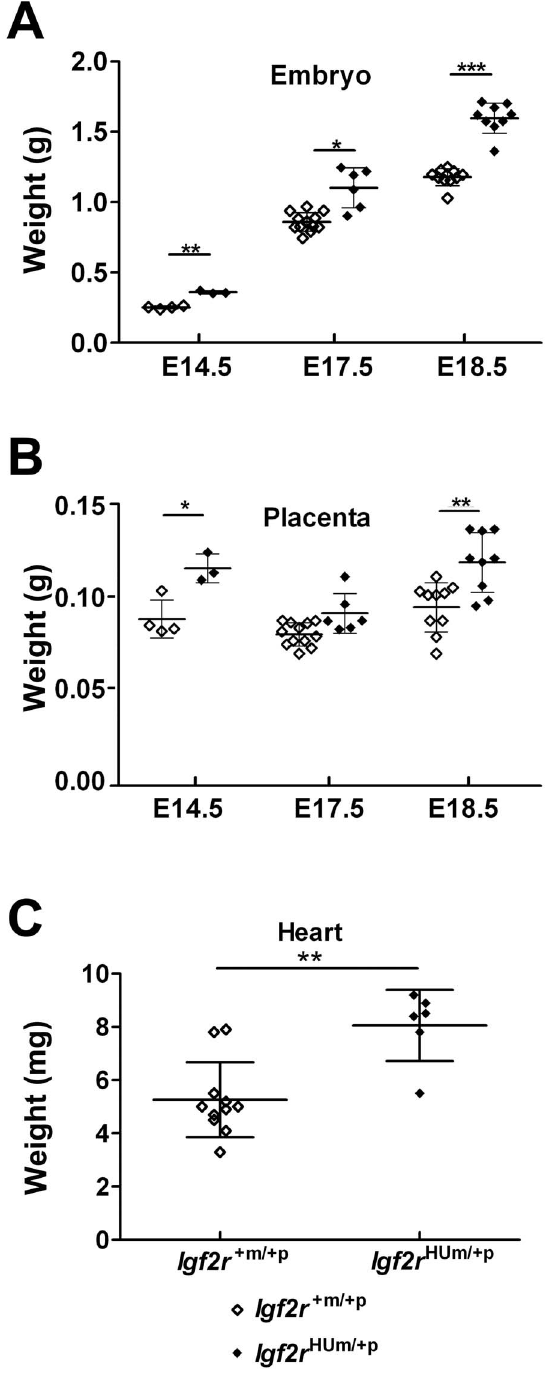
Figure 3. Embryonic, placental and heart growth following maternal transmission of Igf2r + m/HUp . ( A ) Total body weights at E14.5 (WT n=4, Igf2r HUm/ + p n=3), E17.5 (WT n=12, Igf2r HUm/ + p n=6) and E18.5 (WT n=10, Igf2r HUm/ + p n=9) showing gain in weight of Igf2r HUm/ + p . ( B ) Placental weights at E14.5 (WT n=4, Igf2r HUm/ + p n=3) E17.5 (WT n=12, Igf2r HUm/ + p n=6) and E18.5 (WT n=10, Igf2r HUm/ + p n=9). At E14.5 P=0.0148, at E17.5 P=NS, at E18.5 P=0.0037. ( C ) Heart weights at E18.5 (WT n=11, Igf2r HUm/ + p n=6) showing gain in weight of hearts of Igf2r HUm/ + p . *P , 0.05, **P , 0.01, ***P , 0.001. Whiskers 6 standard deviation. Paired t-test.